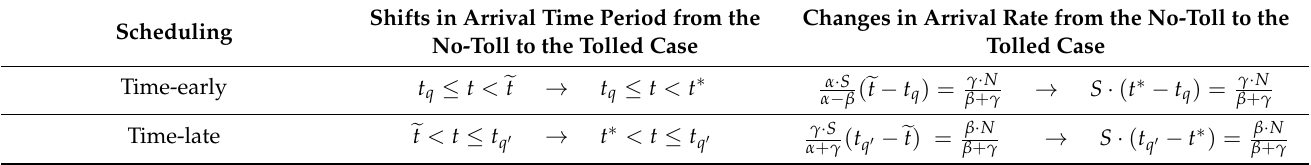
Table 5. Shifts in arrival time period and changes in arrival rate before and after implementing the optimal non-queueing toll